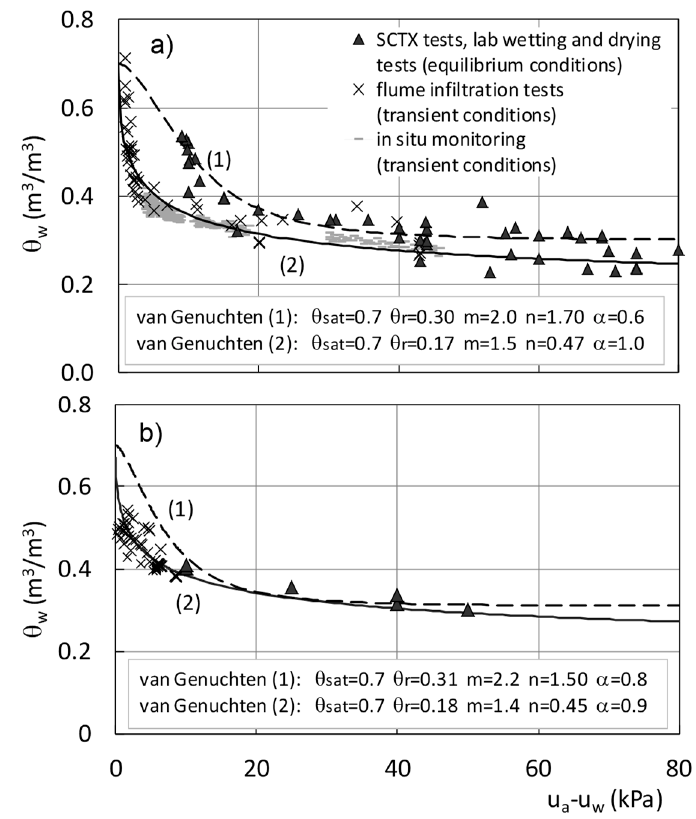
Figure 6. Water retention curves of ( a ) Cervinara and ( b ) Sarno ashes.